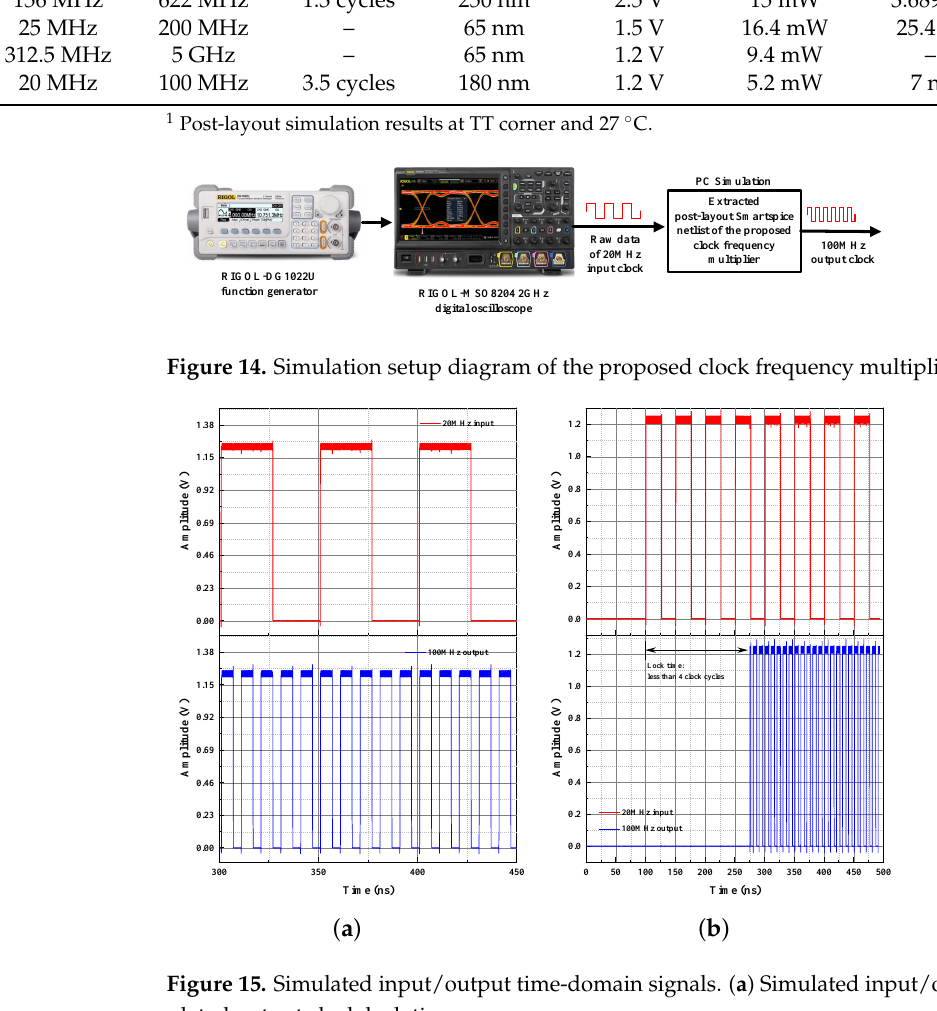
Figure 15. Simulated input/output time-domain signals. ( a ) Simulated input/output clocks; ( b ) Sim- ulated output clock lock time.